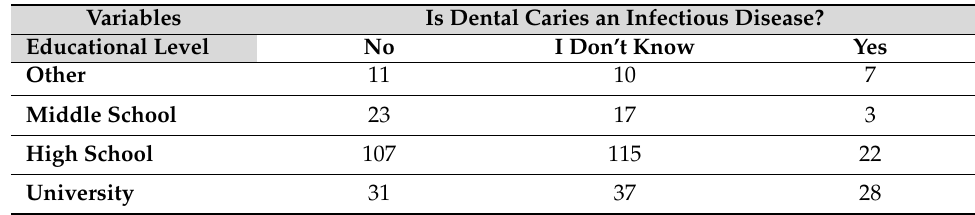
Table 8. Distribution according to information received by dental professionals about dental caries as infectious